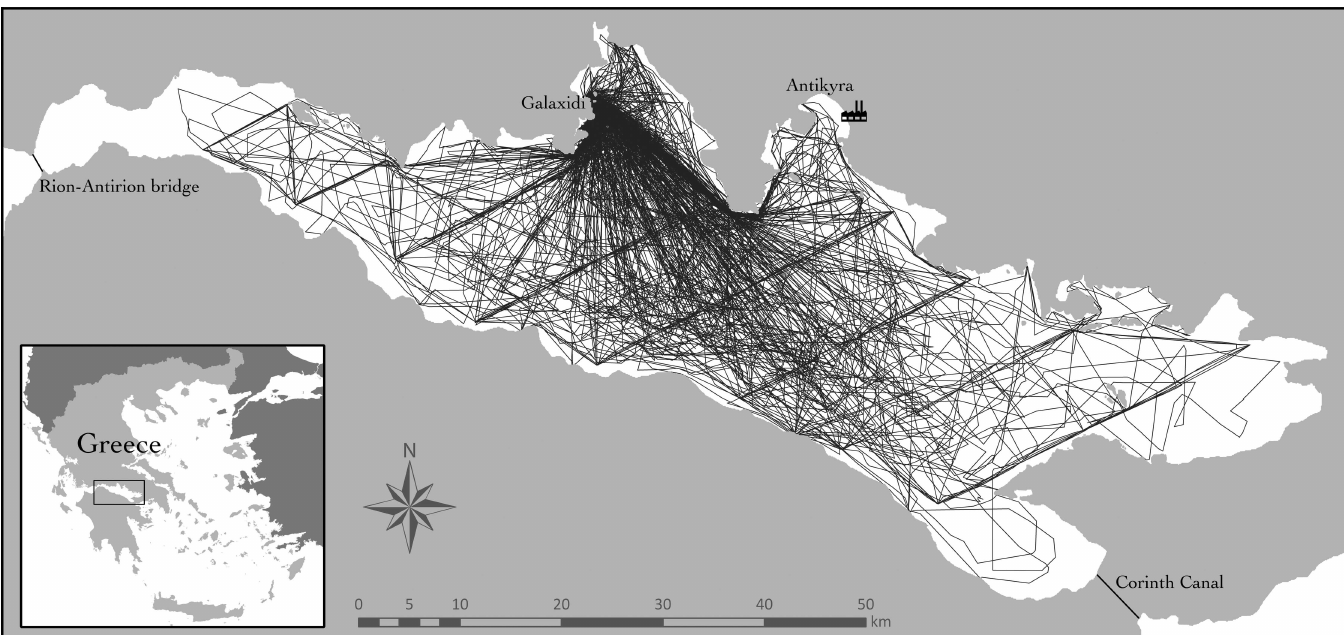
Fig 1. The Gulf of Corinth study area in Greece, with survey tracks in 2011–2015. The locationsshown in the map include: Galaxidi(our base port), the aluminumfactory (indicated by an icon) near Antykira, the artificial Corinth Canalthat connects the Gulf to the AegeanSea and the Strait of Rion (crossed by the Rion-Antirion bridge)that connects the Gulf with the